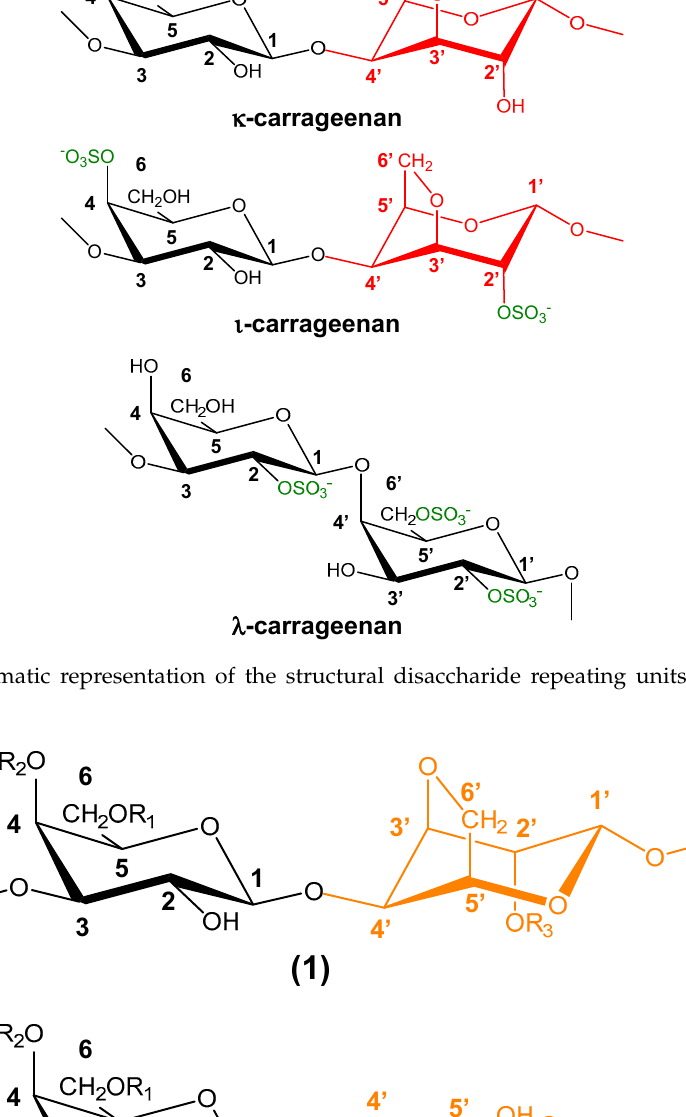
[196]. The blocks are composed of consecutive M residues (MMMMM), consecutive G residues (GGGGGG), and alternating M and G residues (GMGMGM) (Figure 6). Alginates extracted from